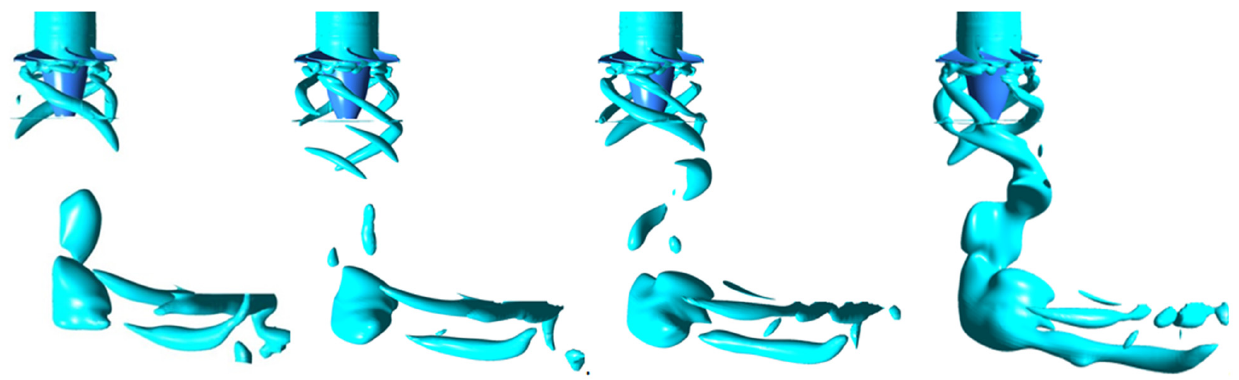
Figure 17. Evolution of the pressure iso-surface at 205 kPa.